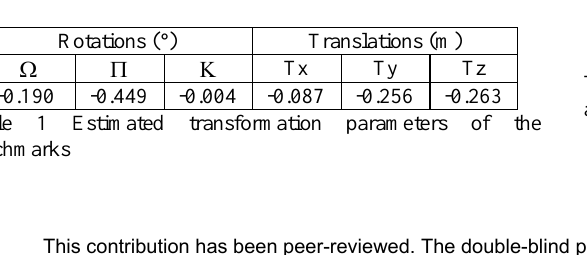
Figure 3 Visualization of fifteen planar surfaces manually extracted from dataset 1